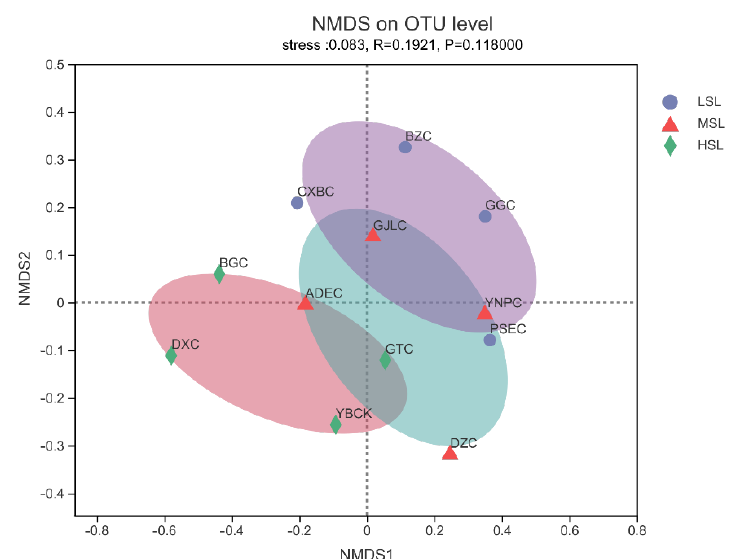
Figure 7. Non-metric multidimensional scaling (NMDS) of microbial community composition in the sampled lakes on the Tibetan Plateau, China.